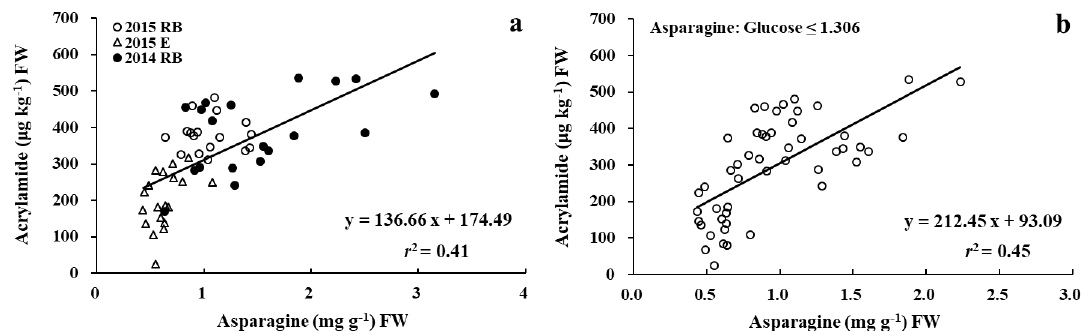
Figure 9. Relationships between acrylamide and asparagine ( a ) for Russet Burbank in two years and Easton in 2015, and ( b ) when asparagine/glucose ≤1.306.